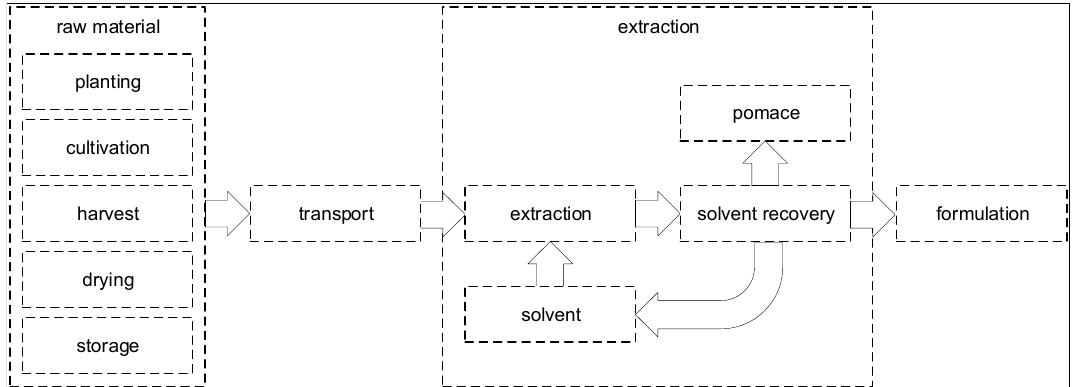
Figure 8. Supply chain for herbal raw materials. Processes 2020 , 8 , x FOR PEER REVIEW